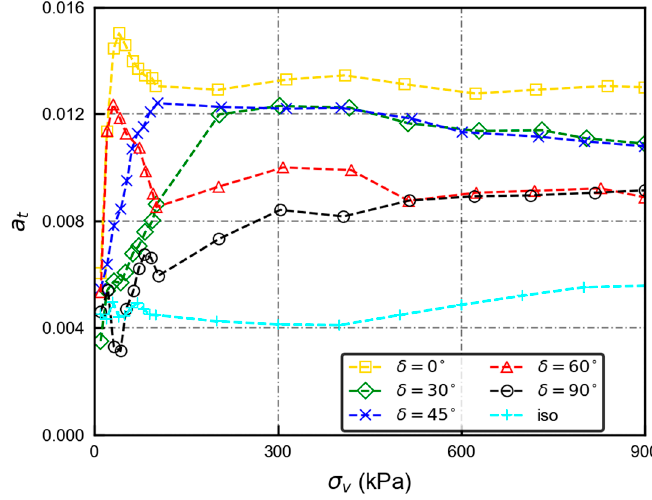
Figure 12. Evolution of a t in different initial anisotropy specimens.